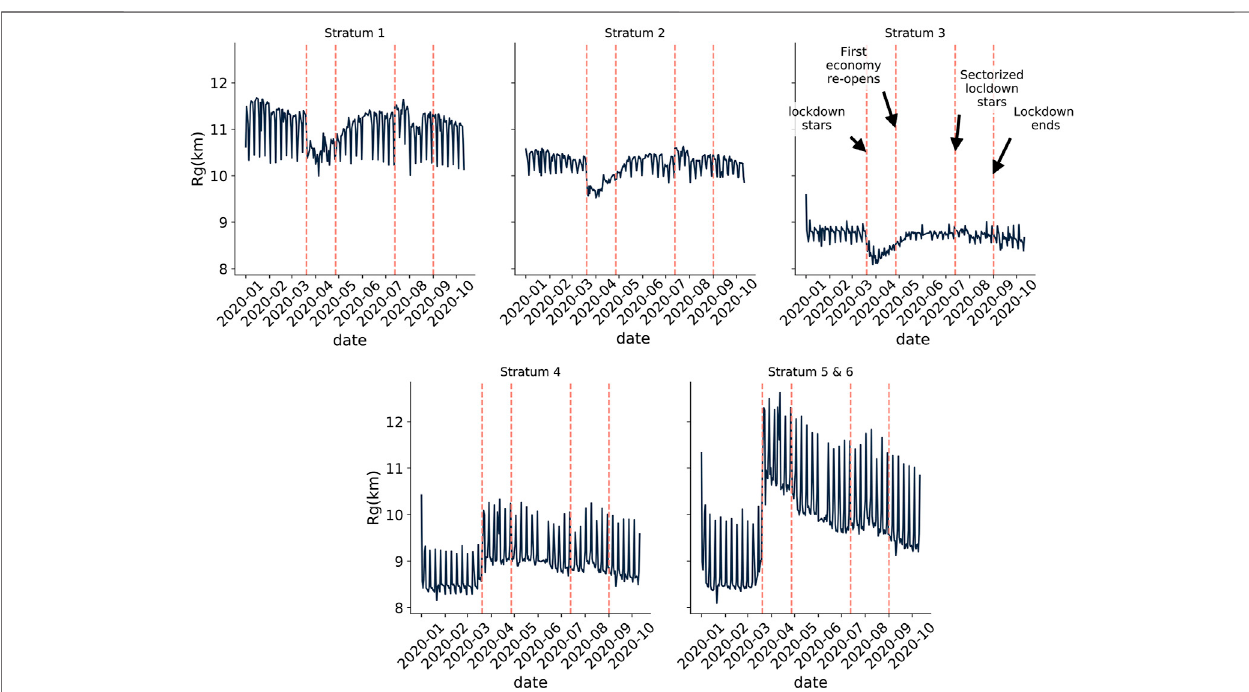
FIGURE 7 | Average Radius of Gyration (Rg) in km by strata. Red dotted lines mark the start of the lockdown (Mar/20), the fi rst economy re-opening (Apr/27), the sectorized lockdown (Jul/13) and the end of the lockdown (Sep/01).